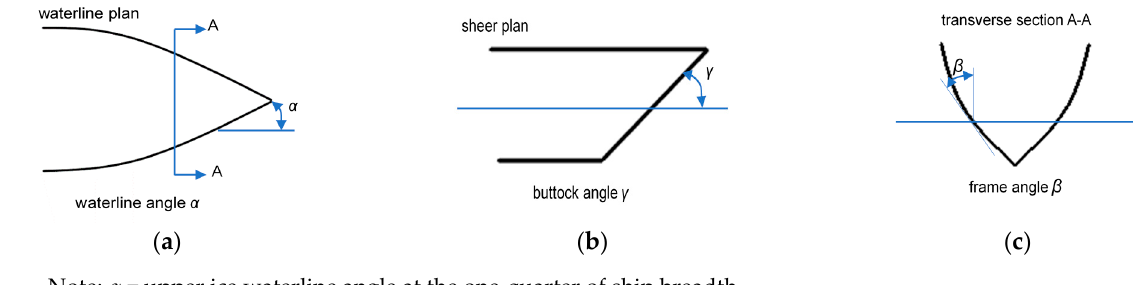
Figure 8. Definition of bow configuration parameters, where ( a ) is α , ( b ) is γ and ( c ) is β , respectively.